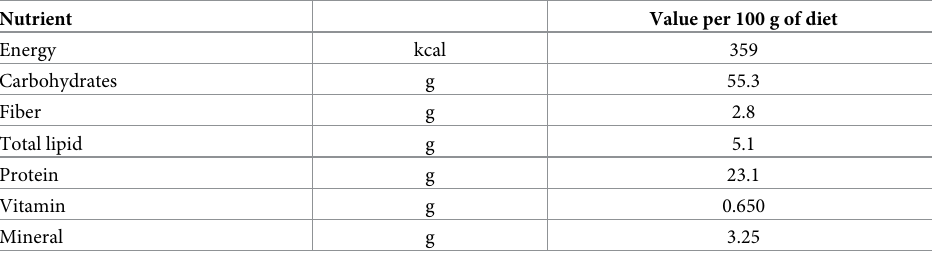
Table 1. Nutritional composition of the